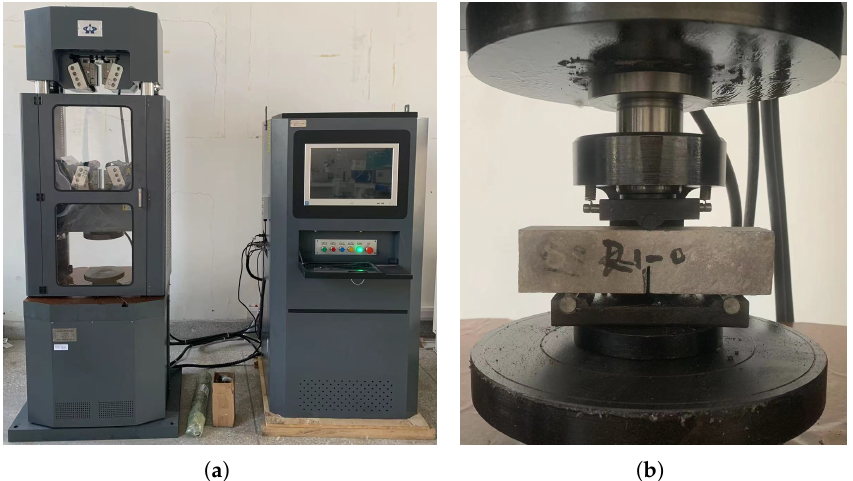
Figure 3. The mechanical testing system and the loading head for the three-point bending